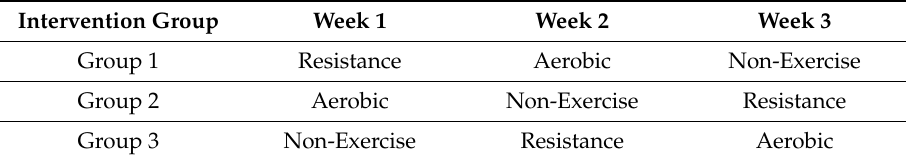
Table 1. Intervention order by